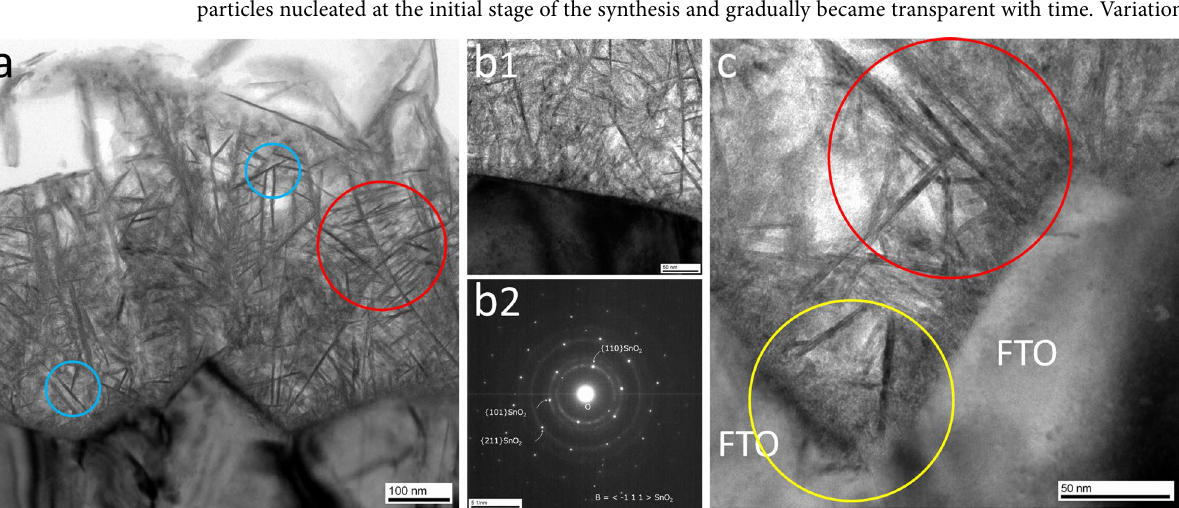
Figure 8. ( a ) Cross-sectional TEM image of the gradient structure of the SnO 2 (101) nanosheet assembled film on the FTO substrate showing branch angles of 90° (type I) (red circle) and 46.48° (type II) (blue circle) between the SnO 2 nanosheets. ( b1 ) Cross-sectional TEM image of the SnO 2 (101) nanosheet assembled film on the FTO substrate. ( b2 ) SAED pattern from ( b1 ) showing the electron diffraction from SnO 2 . ( c ) Cross-sectional TEM image of the SnO 2 (101) nanosheet assembled film on the FTO surface in the depressed valleys showing type I connections (branch angle of 90°) between the SnO 2 nanosheets (red circle), and high surface coverage in the concave area (yellow